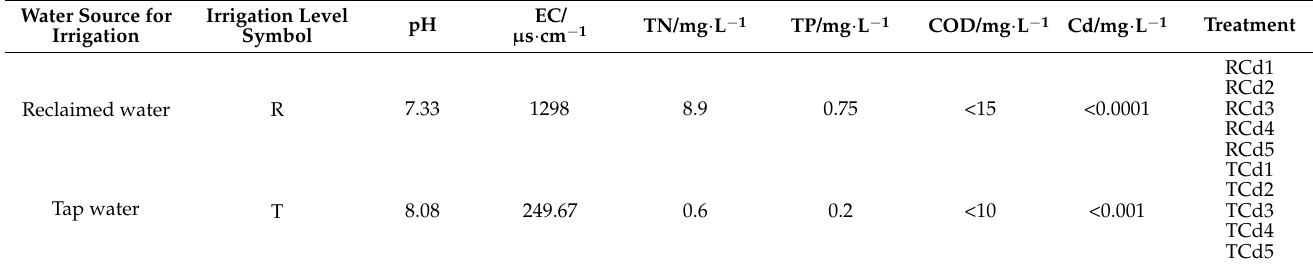
Table 1. Design explanation of different treatments and irrigation water quality